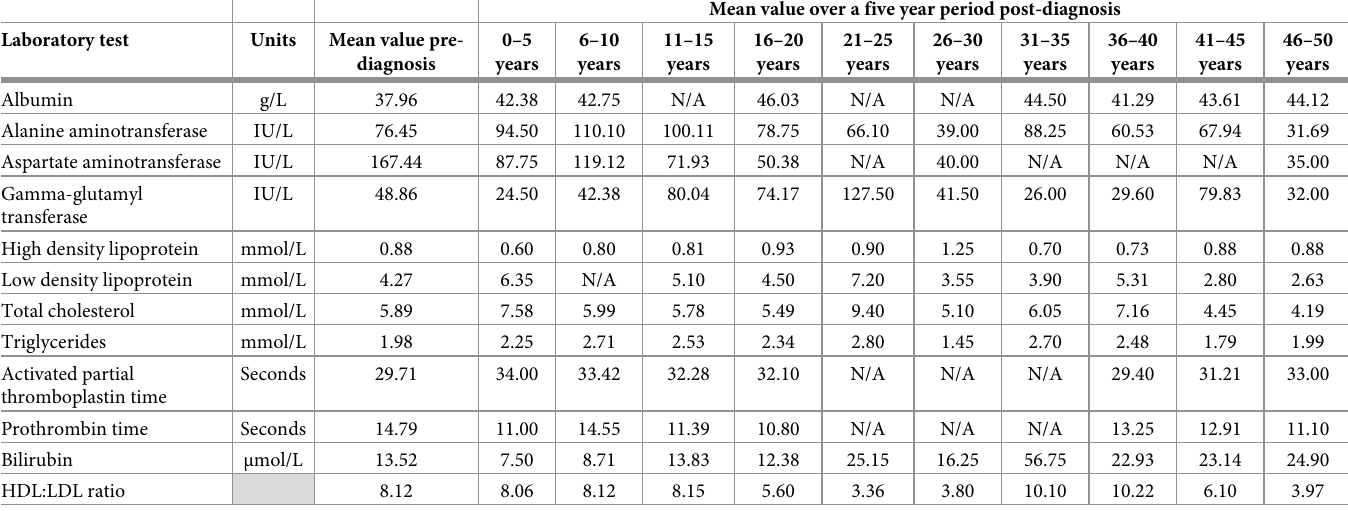
Table 6. Laboratory test results.